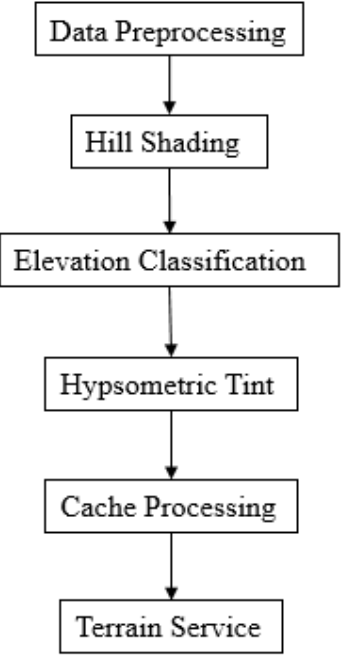
Figure 1. General design for topographical hill shading